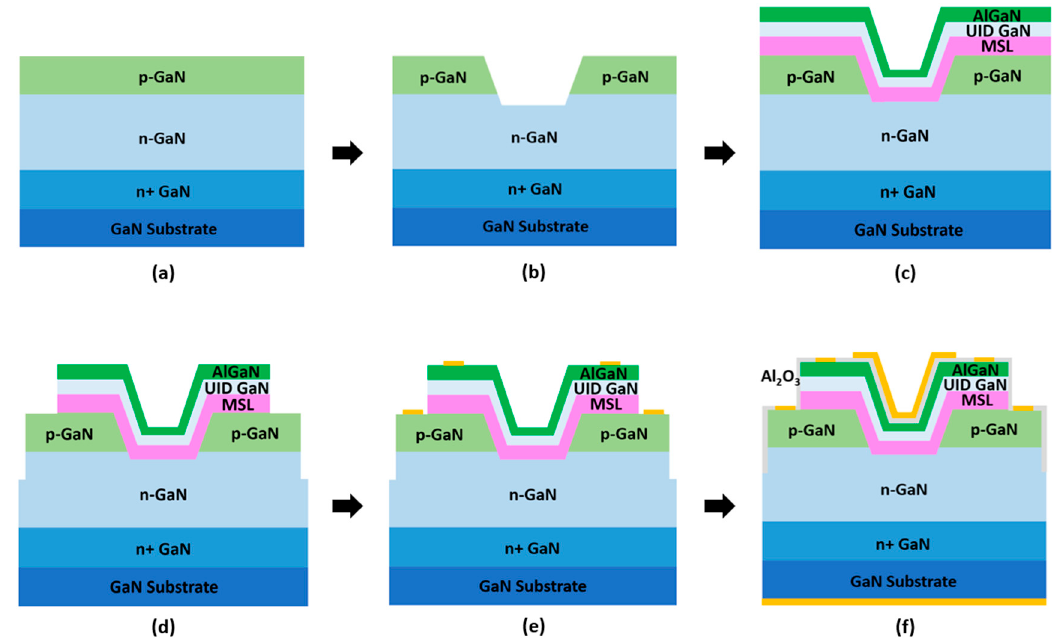
Figure 2. Schematic of the device process flow. ( a ) The p-i-n epitaxial structure containing a 300 nm Mg-doped p-GaN layer on top of a 1-µm n-GaN drift layer. ( b ) Trench etching by ICP-RIE followed by TMAH wet-etching treatment. ( c ) LT-GaN MSL/UID-GaN/AlGaN triple-layer regrowth by MOCVD. ( d ) Two steps of isolation etching by ICP-RIE and Mg dopant activation in the buried p-GaN by RTA in N 2 . ( e ) Ti/Al/Ni/Au metal deposition as the source contact followed by source annealing and Ni/Au metal stack as the p-GaN contact connected to the source through pad metallization (not shown in the fi gure). ( f ) ALD for 12 nm Al 2 O 3 as the gate dielectric layer and gate contact